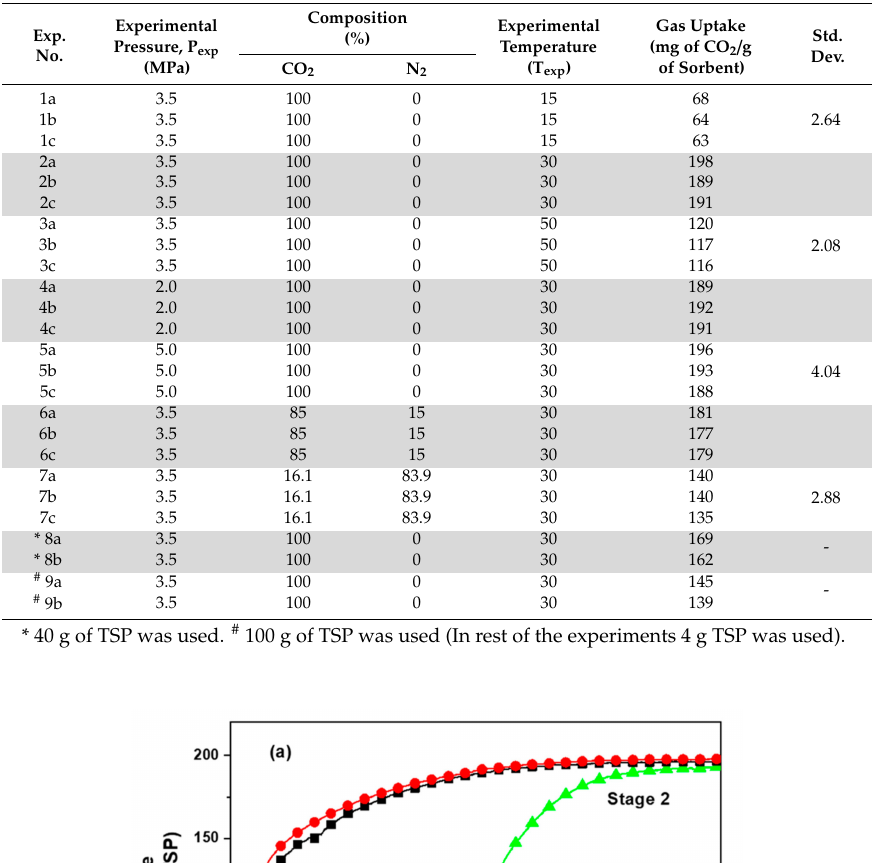
Table 1. Summary of the experimental conditions, gas composition, and CO 2 uptake data along with standard deviation for all the kinetic experiments carried out at small (4 g), medium (40 g), and large scale (100 g).